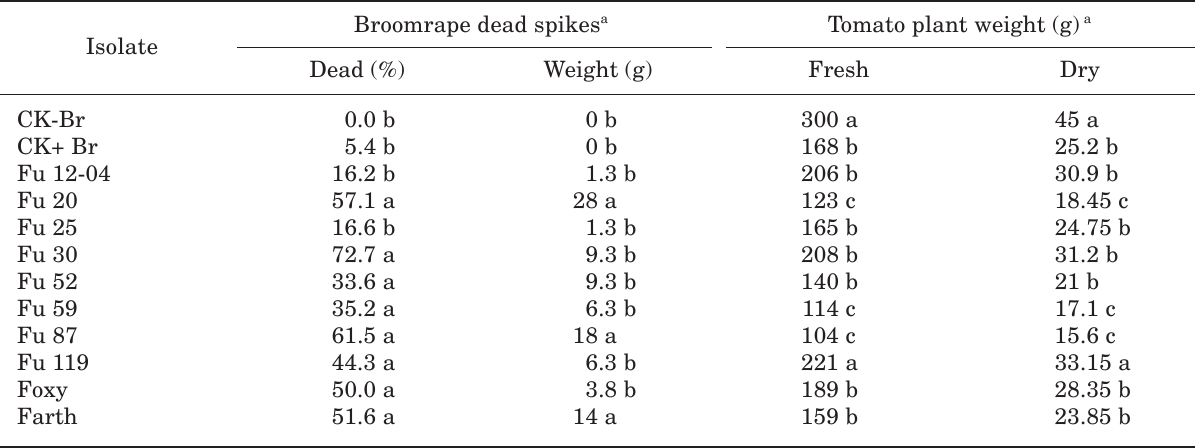
Table 2. Effect of the most promising Fusarium spp. isolates on the number and weight of broomrape dead spikes, tomato fresh and dry